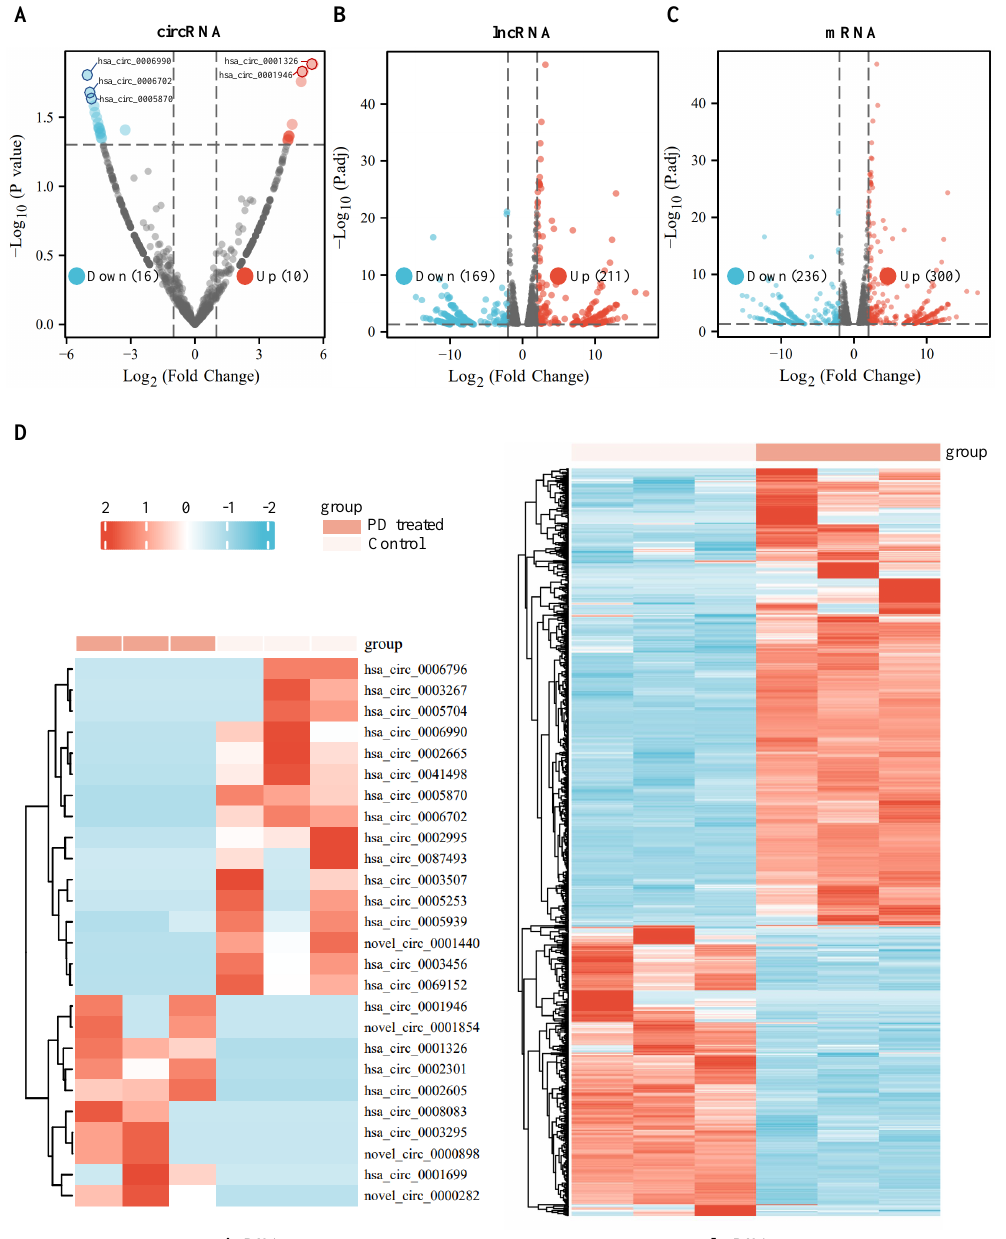
Figure 1. Expression profiles of differentially expressed RNAs in the PD-treated cells and the controls. ( A – C ) Volcano plots of differentially expressed circRNAs ( A ), differentially expressed lncRNAs ( B ), and differentially expressed mRNAs ( C ) between the PD-treated A549 cells group and the controls. X axis: log2 ratio of circRNA expression levels ( A ), lncRNA expression levels ( B ), and mRNA expression levels ( C ) between the two groups. Y axis: false discovery rate values ( − log10 transformed) of p values. ( D ) Heatmaps of differentially expressed circRNAs and differentially expressed lncRNAs between the PD-treated A549 cells and the controls. Red indicates up-regulation, and blue indicates